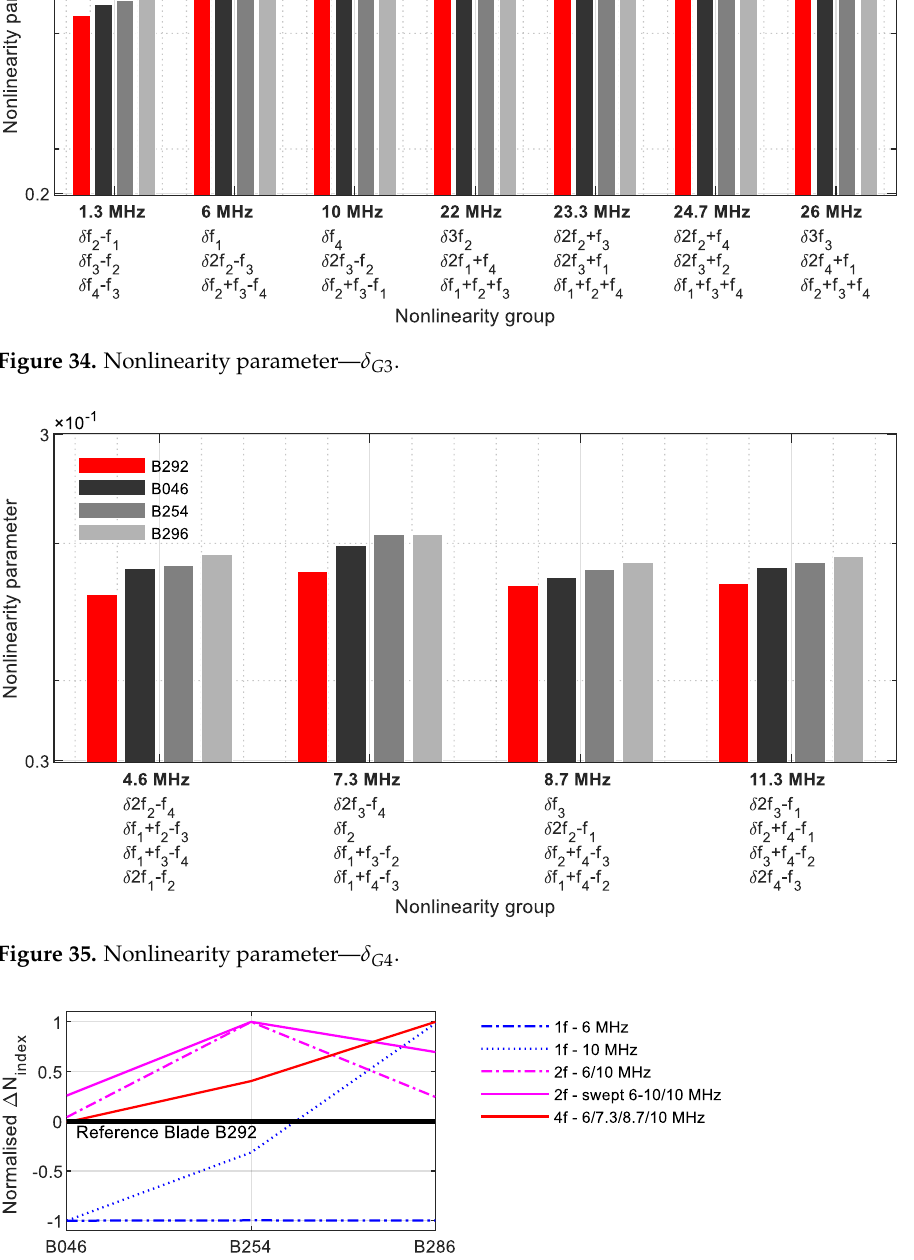
Figure 36. Comparison N index values.